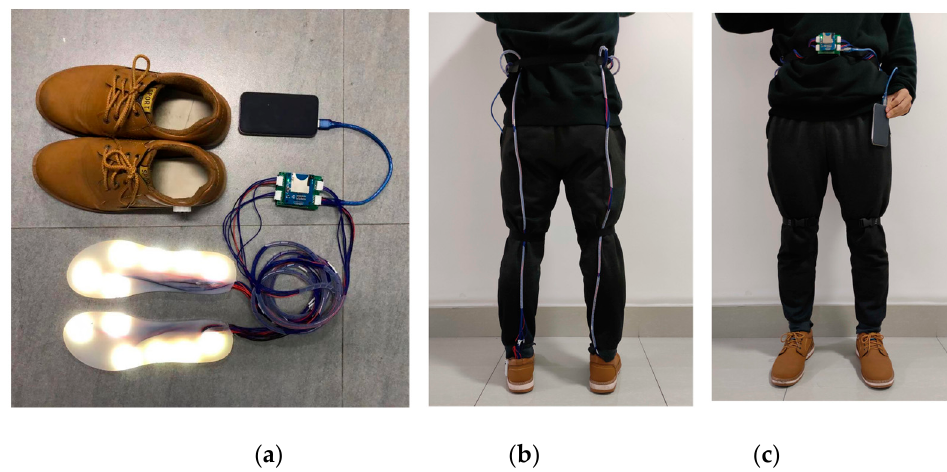
Figure 13. COP values of the second insole solution.